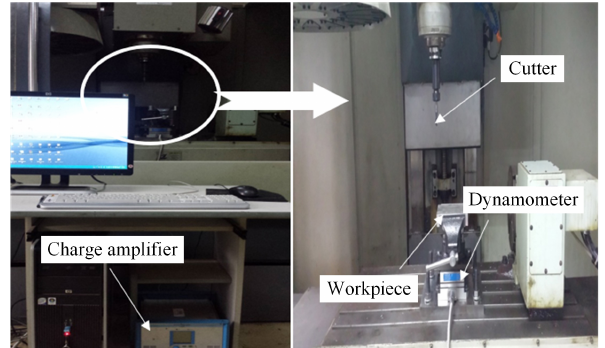
Figure 1. Experimental platform.